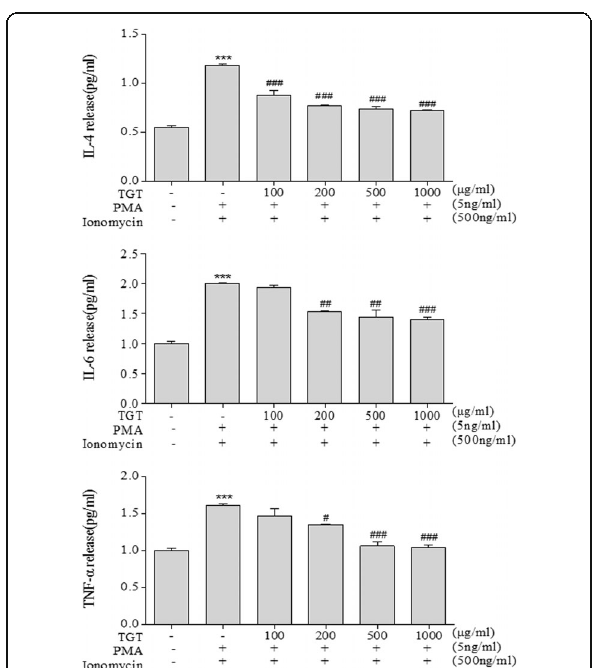
Fig. 2 Effect of TGT on the release of pro-inflammatory cytokines in HMC-1 cells. PI-stimulated HMC-1 cells were treated with or without different doses of TGT for 24 h. The levels of secreted pro-inflammatory cytokines in the cell culture supernatant were measured by ELISA. *; compared to control. #; compared to stimulated cells. Control; HMC-1 with PI ( − ), Stimulation; HMC-1 with PI